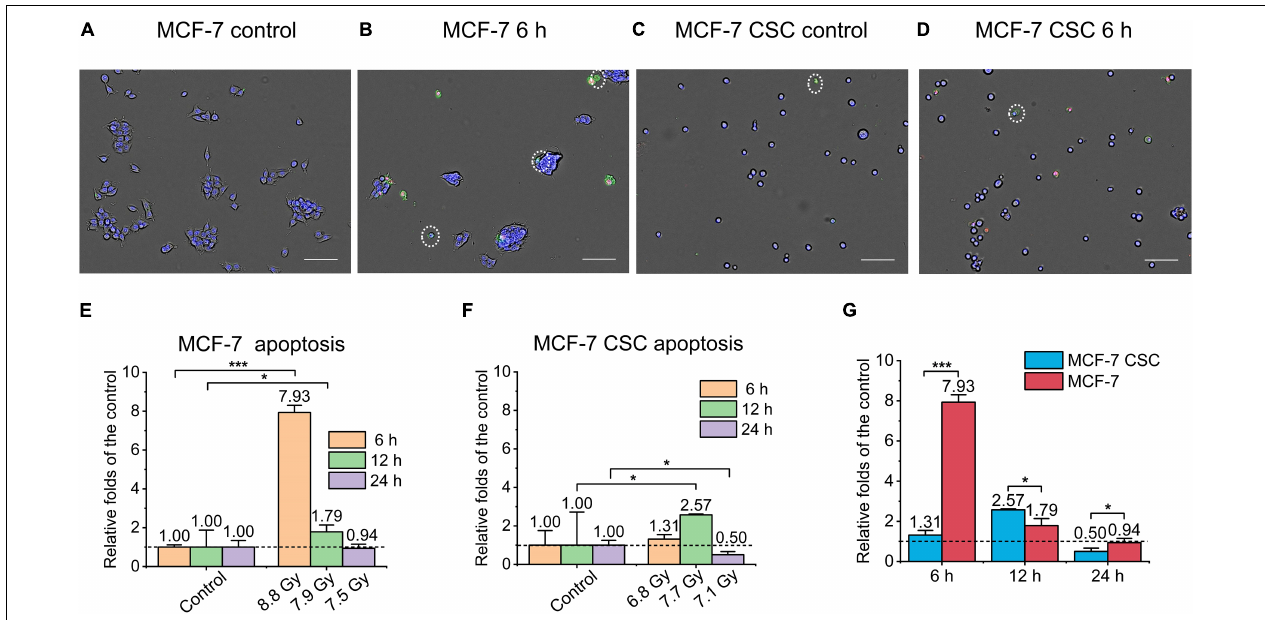
FIGURE 2 | Apoptosis of irradiated MCF-7 cells and MCF-7 CSCs. (A–D) Representative images of control groups and irradiated MCF-7 cells and MCF-7 CSCs at 6 h which were stained with annexin V and PI. Apoptotic cells were marked with white circles. Scale bars: 100 µ m. (E,F) Compared with the relative controls, the relative increasement of the apoptosis proportion for irradiated groups at 6, 12, and 24 h. (G) The increasement of the apoptosis proportion between irradiated MCF-7 cells and MCF-7 CSCs. * P < 0.05; *** P <